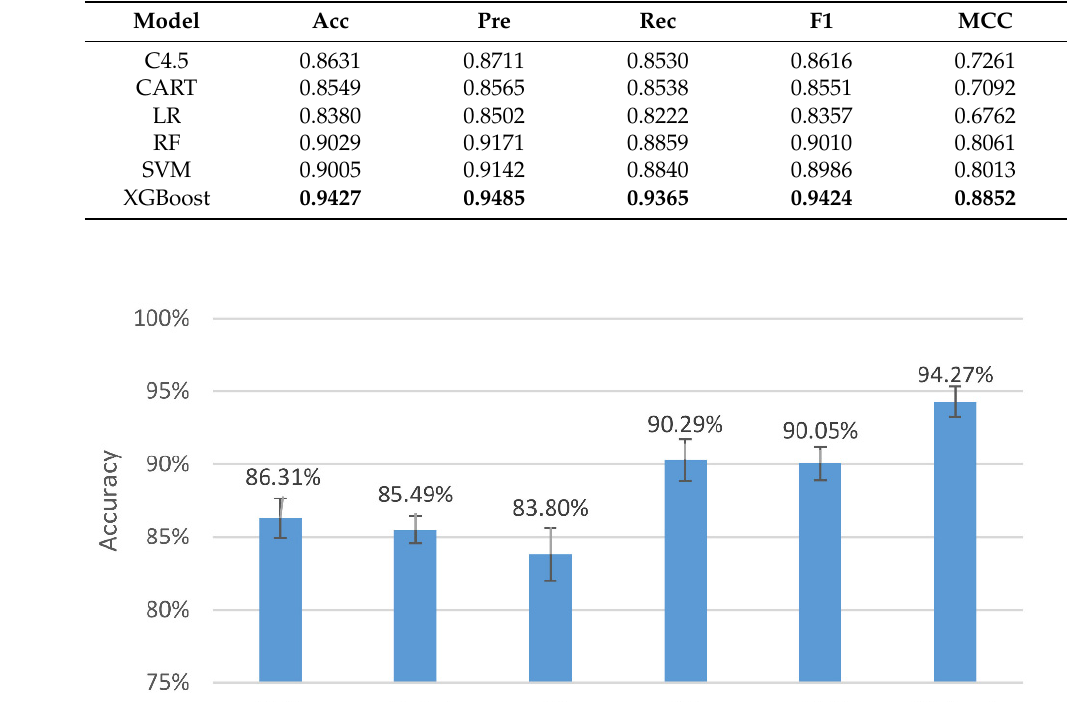
Table 3. Generalizing model for the two-level stress classification (high and low stresses).